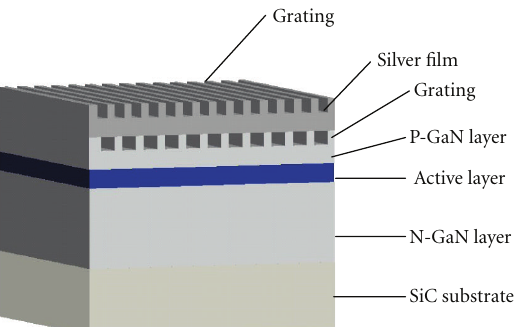
Figure 3: Physical model of an LED with a double-grating displace- ment structure.